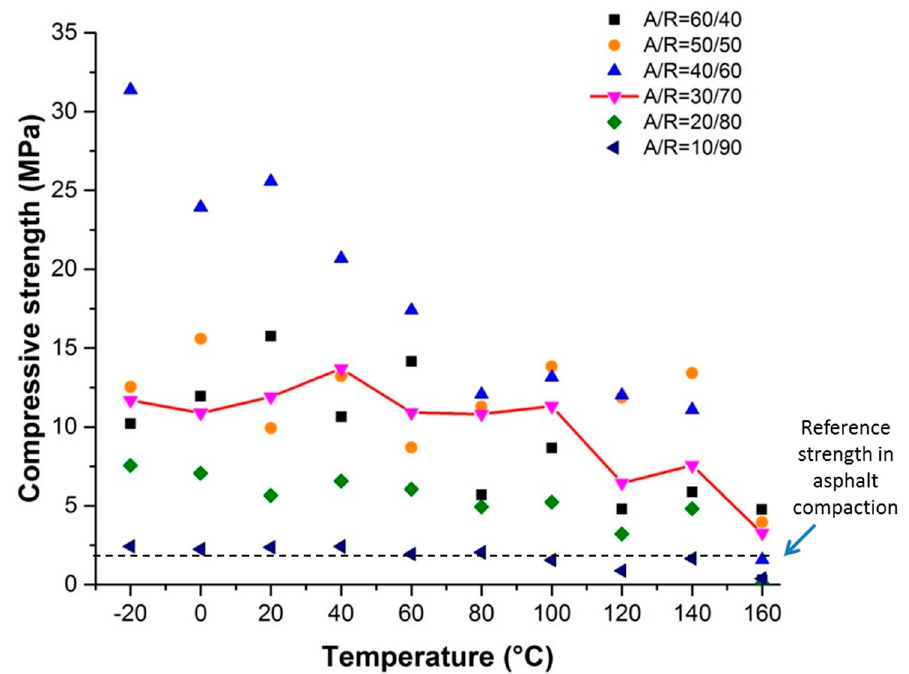
Figure 7. Compressive strength of capsules fabricated with varying A/R ratios cured under different temperatures.